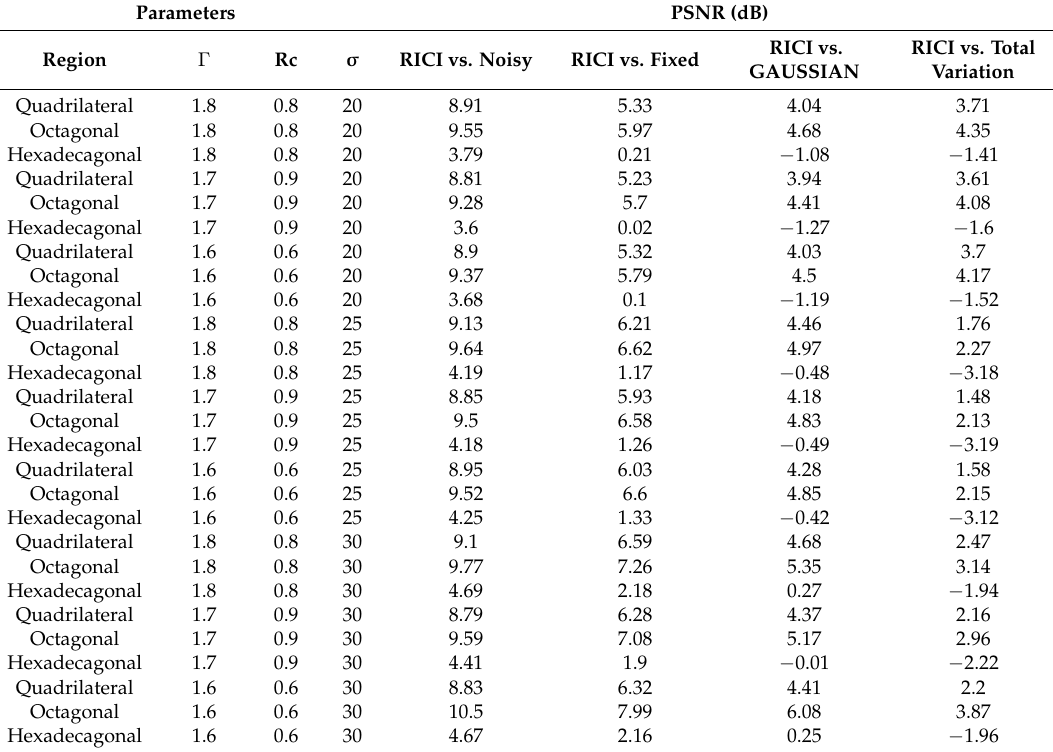
Table 2. PSNR improvements for shoulder X-ray images denoised using the proposed 2D LPA-RICI method vs. the competitive